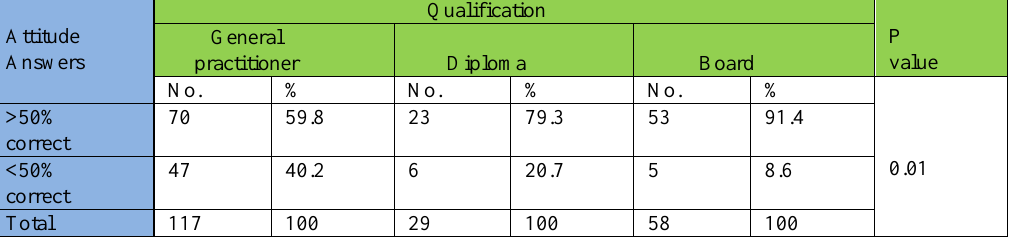
Table.6 relationships between attitude category and qualification